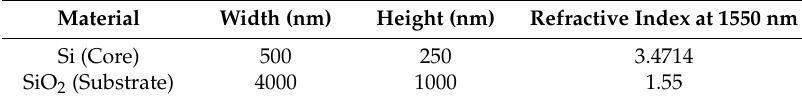
Table 1. Materials and dimensions of waveguide.